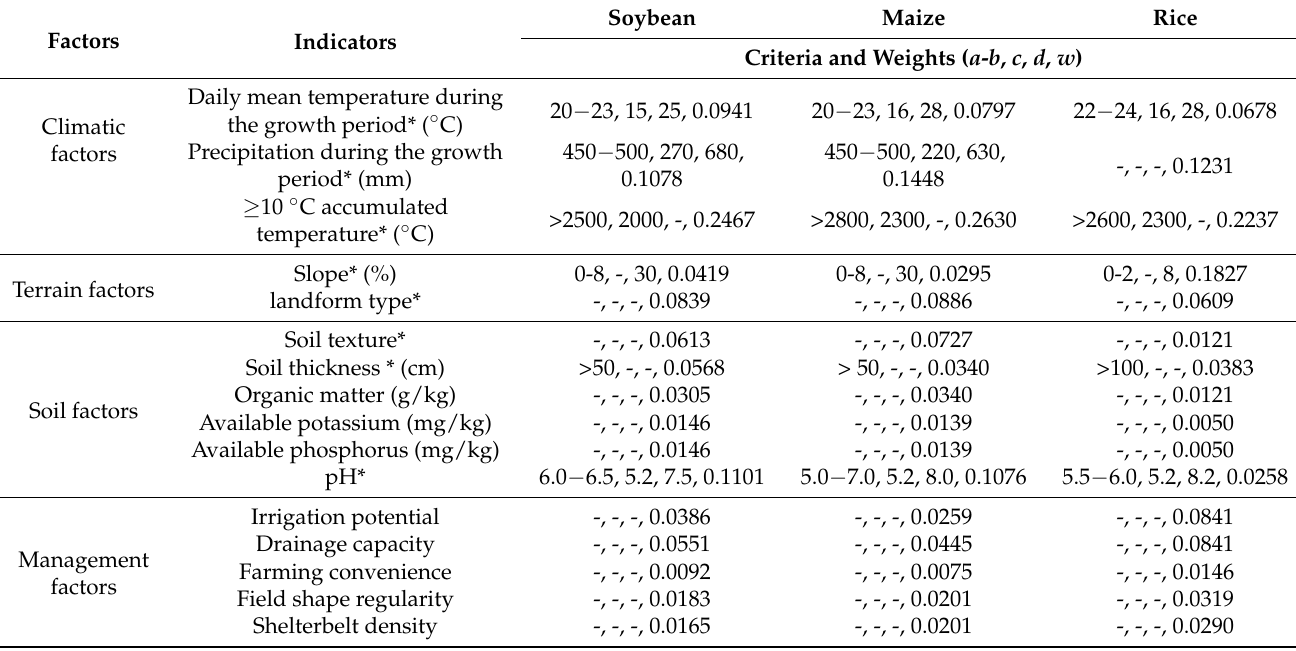
Table 1. Land suitability evaluation index system and quantitative standard for crops.